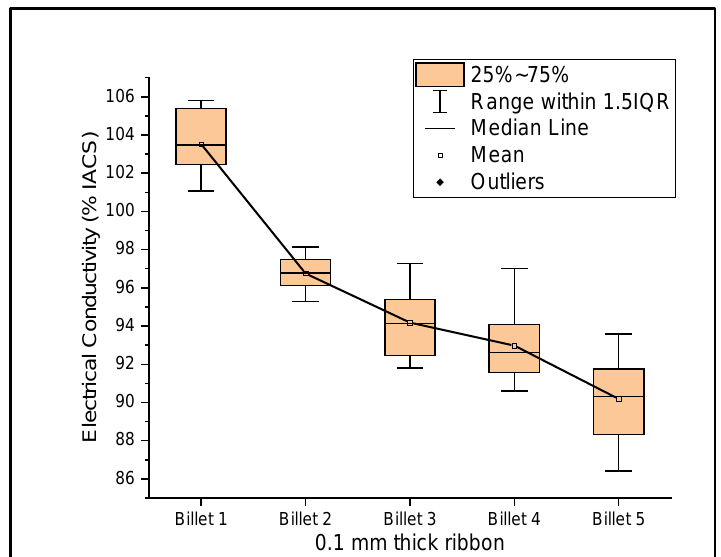
Figure 8. The electrical conductivity of all billets at a 0.1 mm thickness.